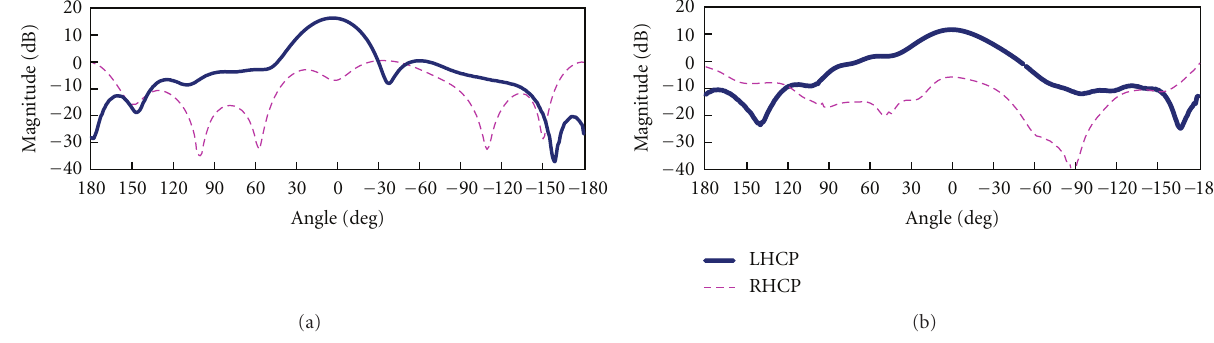
Figure 5: Radiation patterns of Array A measured at 3110 MHz. (a) x - z plane. (b) y - z plane.